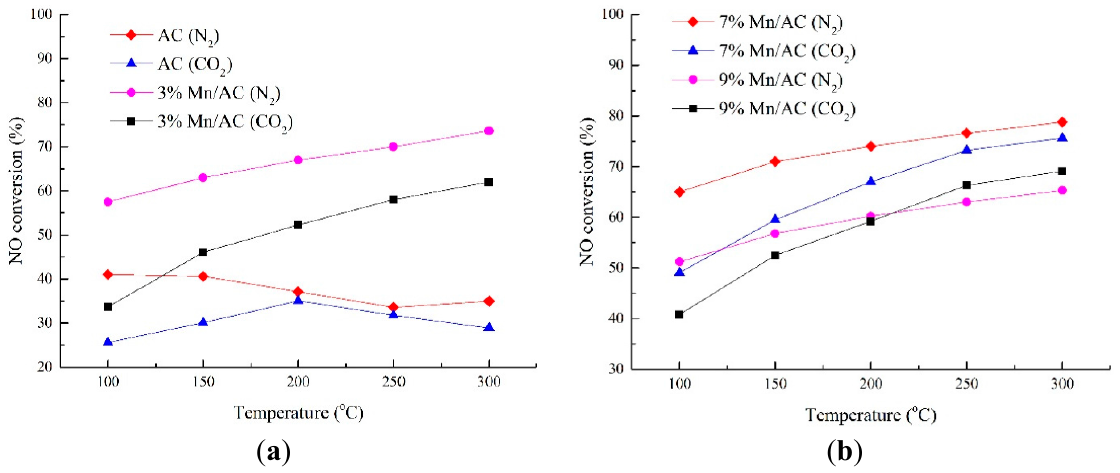
Figure 2. NH 3 -SCR using Mn/AC catalyst under CO 2 and N 2 atmosphere. Other conditions: 800 ppm NO; 800 ppm NH 3 , 6% O 2 and space velocity 3408 h − 1 .